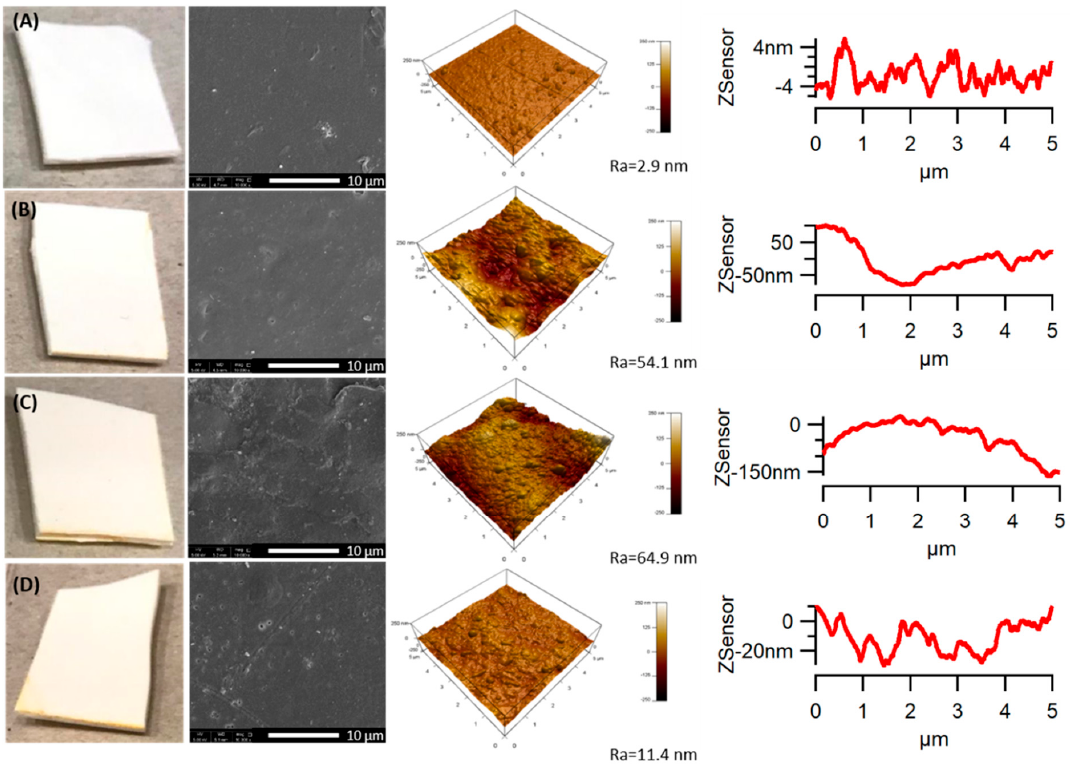
Figure 2. SEM and AFM images of PLA/TiO 2 samples before and after accelerated weathering: ( A ) 0 ( B ) 500 h; ( C ) 1000 h and ( D ) 2000 h. Note: Ra represents the roughness h; ( B ) 500 h; ( C ) 1000 h and ( D ) 2000 h. Note: Ra represents the roughness parameter.